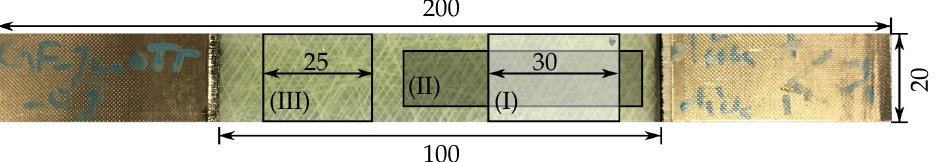
Figure 1. Dimensions (in mm) of the specimens used for static and fatigue analysis and the areas used for (I) matrix crack counting, (II) thermographic imaging, and (III) strain measurement within the specimen gauge length at the front